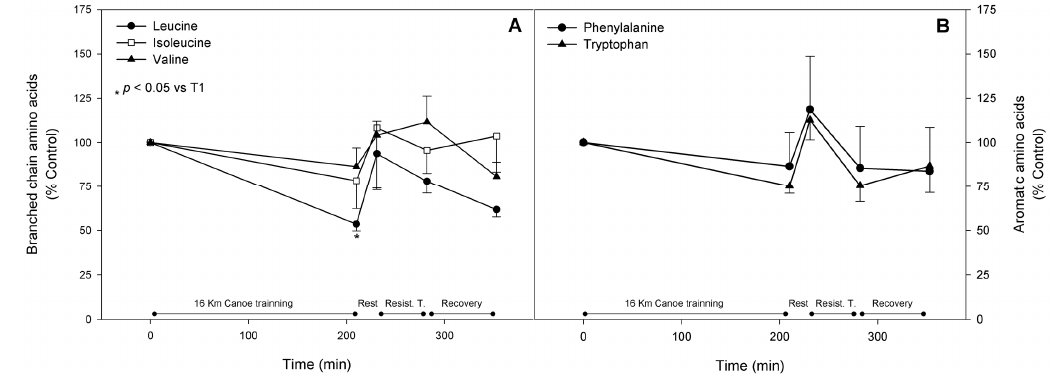
Figure 6. Branched chain ( A ) and aromatic ( B ) amino acids. Amino acid parameters were assessed as described in materials and methods and are represented as mean ± standard error of percentage values against control. * Indicates statistical difference against control values ( p <